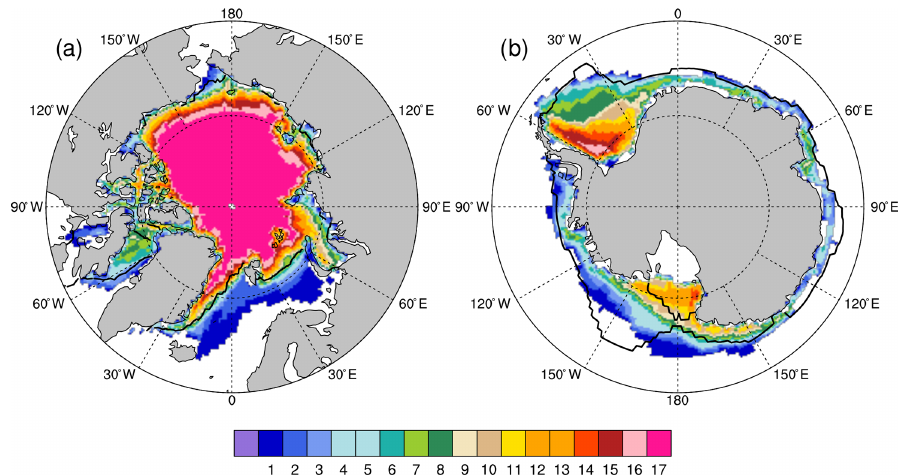
Figure 3. Comparison of the piControl sea ice distributions (a) in the Northern Hemisphere for August–September and (b) in the Southern Hemisphere for February–March. For each 1 ◦ × 1 ◦ longitude–latitude grid cell, the figure indicates the number of models that simulate at least 15% of the area covered by sea ice. The observed 15% concentration boundaries (black lines) are the 1870–1919CE interval based on the Hadley Centre Sea Ice and Sea Surface Temperature (HadISST; Rayner et al., 2003) dataset. See Figs. S2 and S4 for individual model